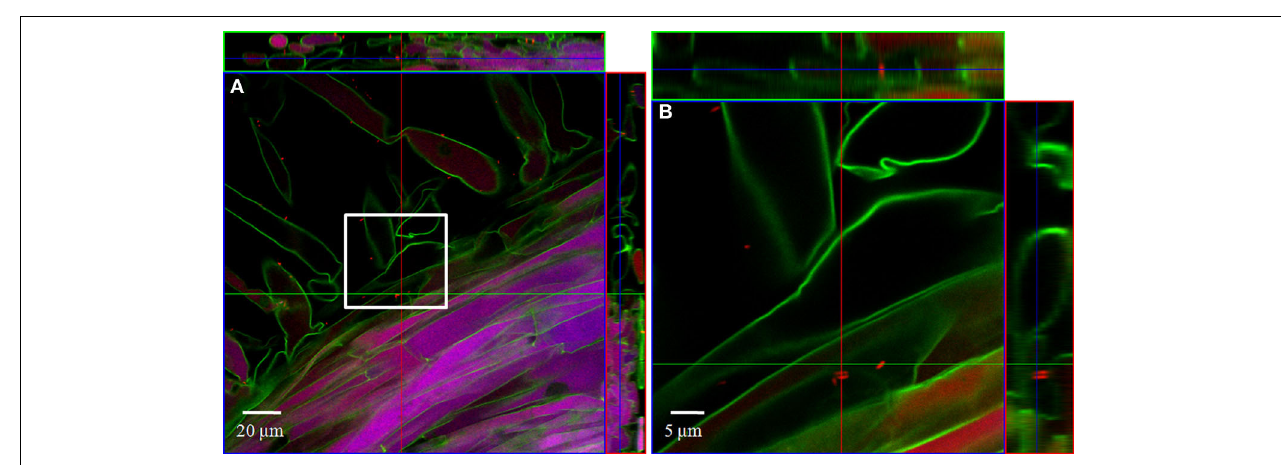
growth in an axenic system. Probe Cy3 marked 338, I, II, III was applied during FISH procedure (red signal). (B) is an enlarged capture of the area marked in (A)